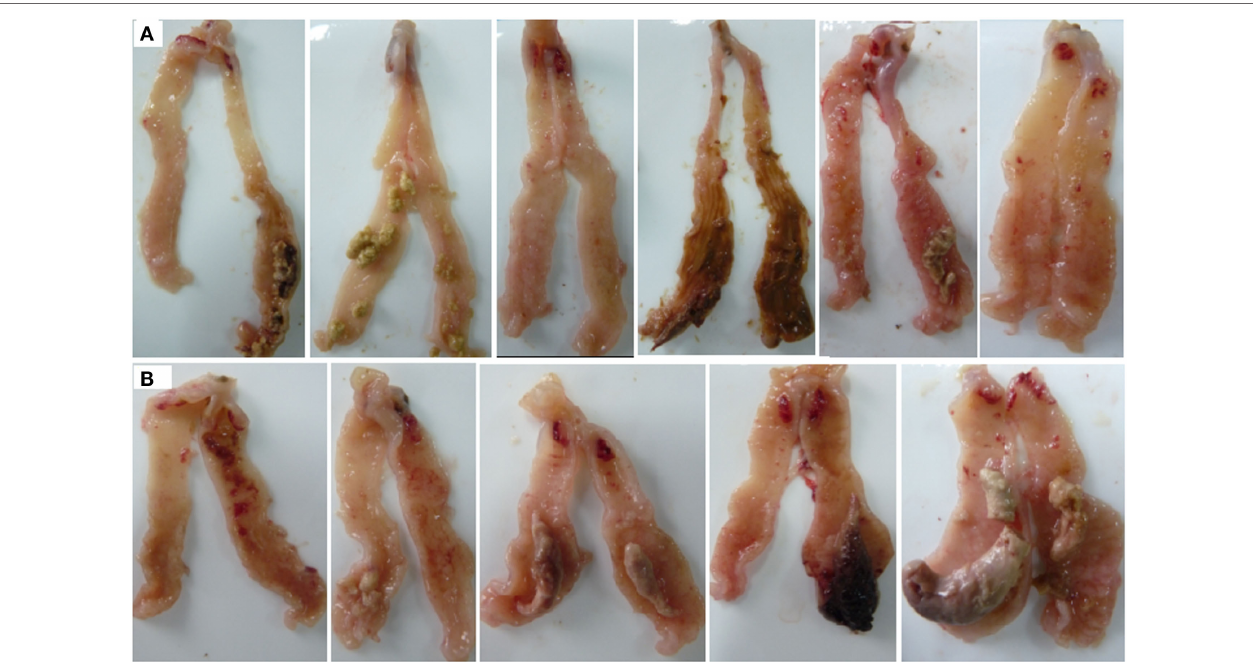
FigUre 1 | Gross lesions in the ceca of Eimeria tenella -infected chicks. (a) Chickens infected with E. tenella . (B) Dual-infected chickens with avian leukosis virus and E.